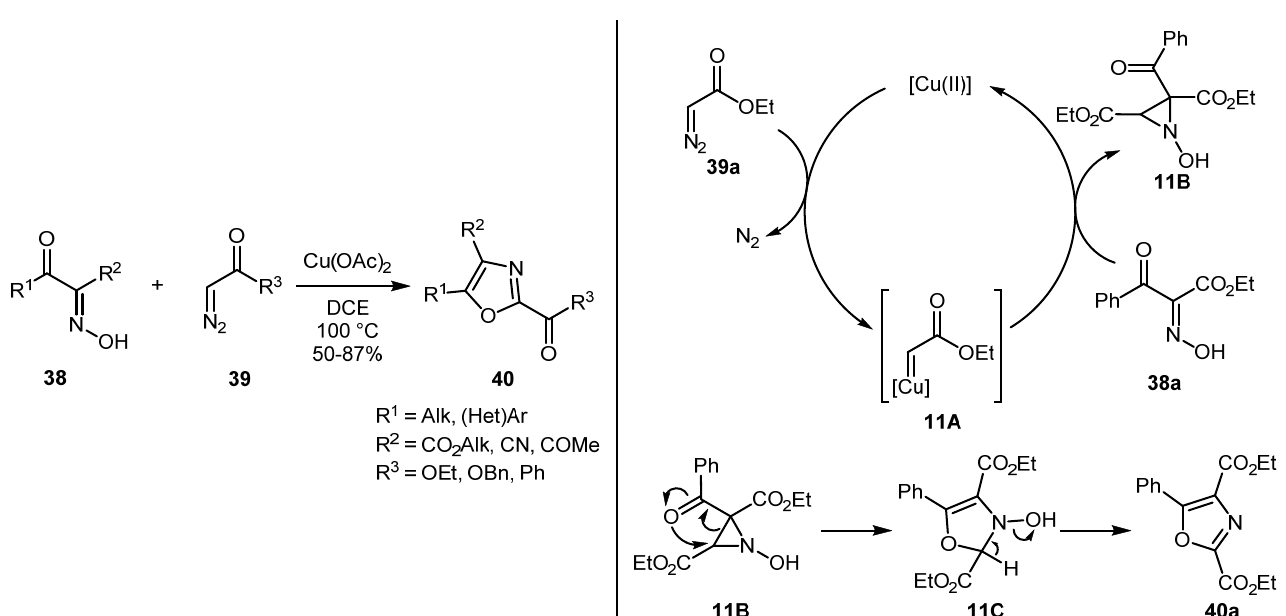
Molecules 2021 , 26 , x FOR PEER REVIEW